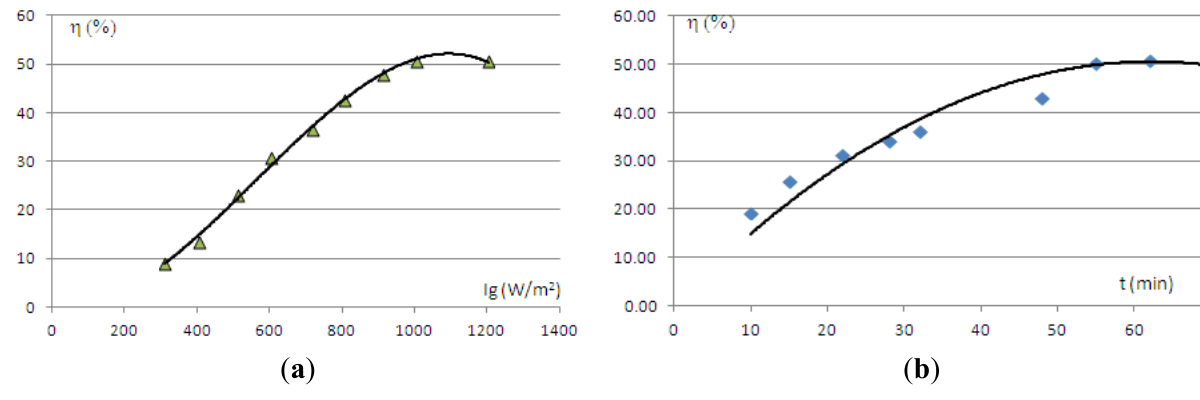
(W/m 2 ) and ( b ) time t g